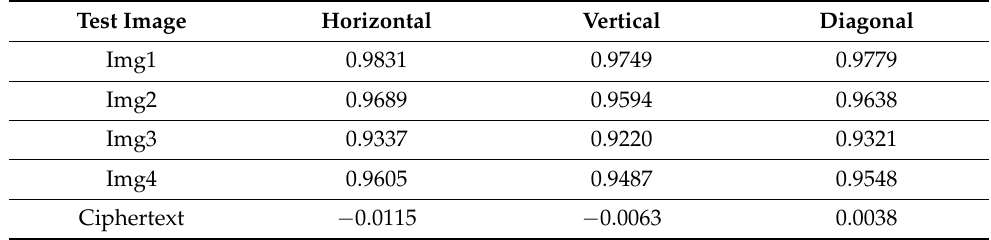
Table 1. Correlation coefficient between adjacent pixels of plaintext image and ciphertext image in each of three directions.